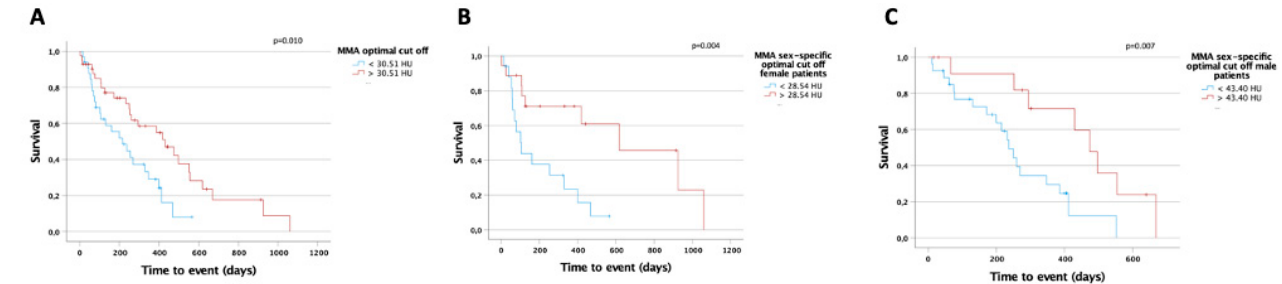
Figure 5. The MMA is a predictor for overall survival in patients with palliative treatment for CCA. ( A ) CCA patients with an MMA above 30.51 Hounsfield Units (HU) live significantly longer compared to patients with a MMA value below this ideal cut-off. Both in female (( B ), 28.54 HU) and male patients (( C ), 43.40 HU), the ideal sex-specific cut-off values have a significant prognostic value regarding median OS. Table 3. Multivariate Cox regression analysis for the prediction of overall survival.